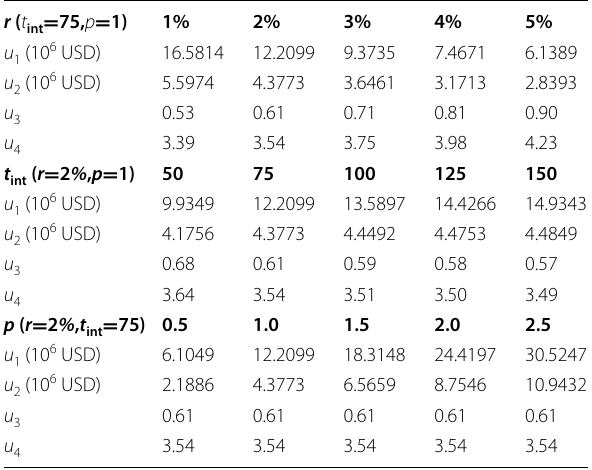
Table 3 The first-four central moments under different